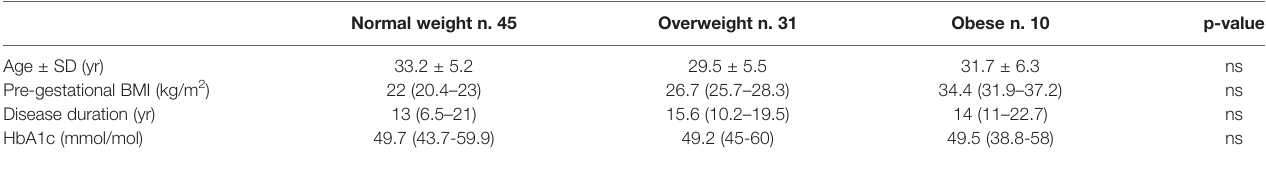
TABLE 2 | Pregnancy Outcomes.